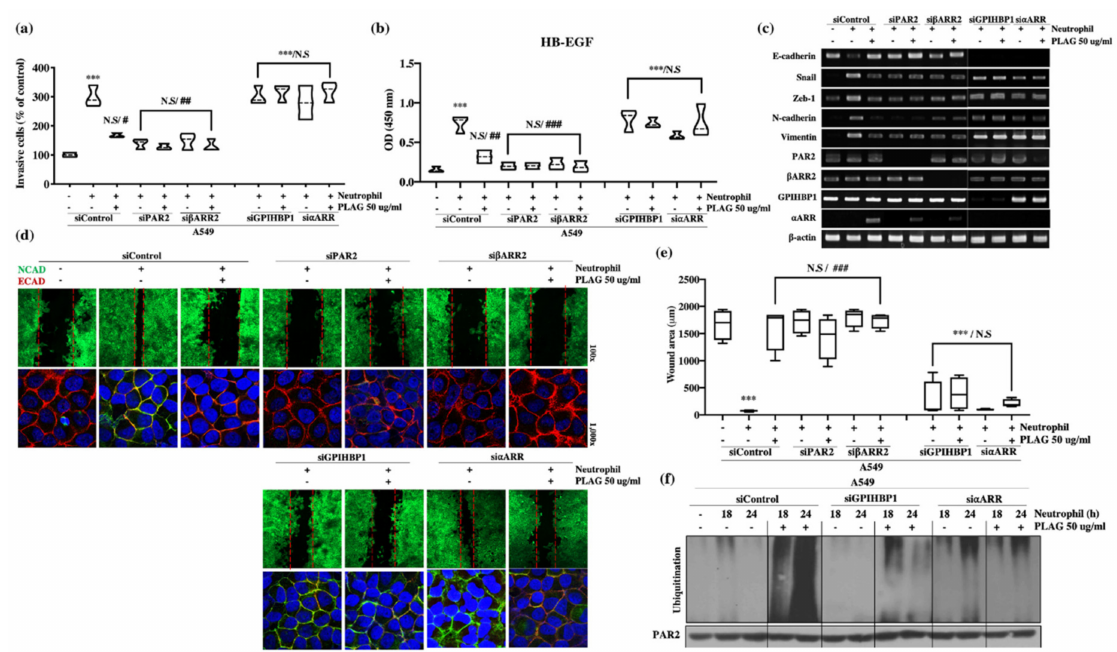
Figure 6. PLAG inhibition of neutrophil-induced invasive activity in A549 cells verified by silencing of PAR2 / β ARR2 and GPIHBP1 / α ARR cascade: ( a ) Neutrophil-induced enhancement of invasive